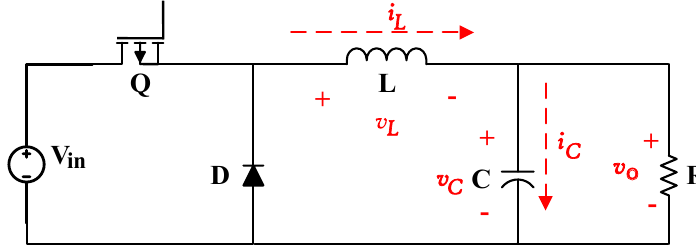
Figure 1. Ideal DC–DC buck converter